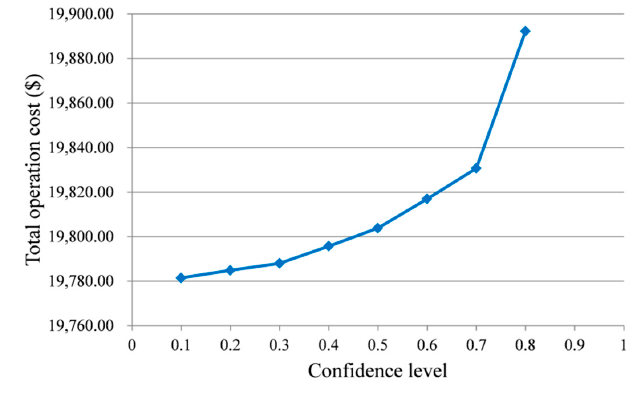
Figure 5. System operational flexibility under different confidence level.